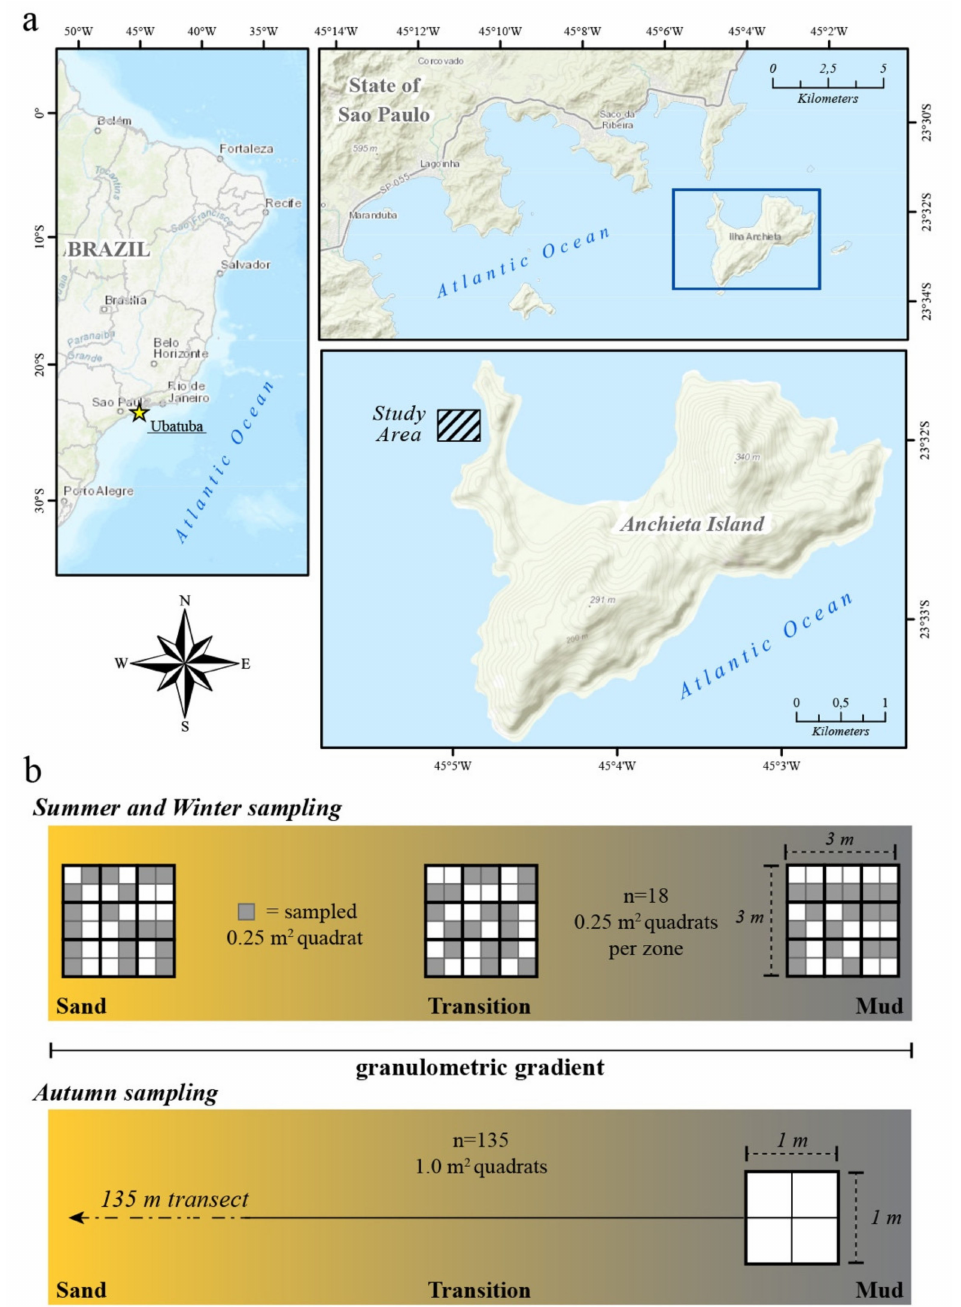
Figure 1. Study area and U. noronhensis sampling methods employed at Anchieta island, Ubatuba, Brazil. ( a ) Map showing the sampled area (hatched rectangle). The sediment gradient goes from mud to sand in an east to west transect. ( b ) Schematic representation of the sampling methods used to estimate U. noronhesis densities through burrow opening counts during summer and winter using a 9 × 9 m quadrat for each zone and the autumn sampling method using a 1 × 1 m quadrat along a 135 m transect. Representation not to